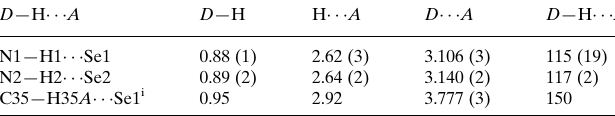
Hydrogen-bond geometry (A˚ , (cid:3)